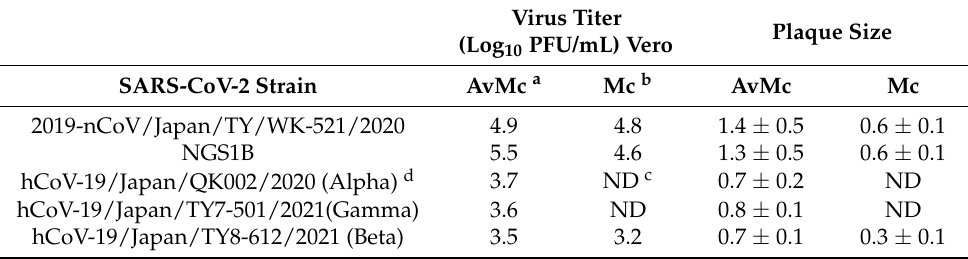
Table 3. Virus titers and plaque size of four SARS-CoV-2 strains using Vero cells.